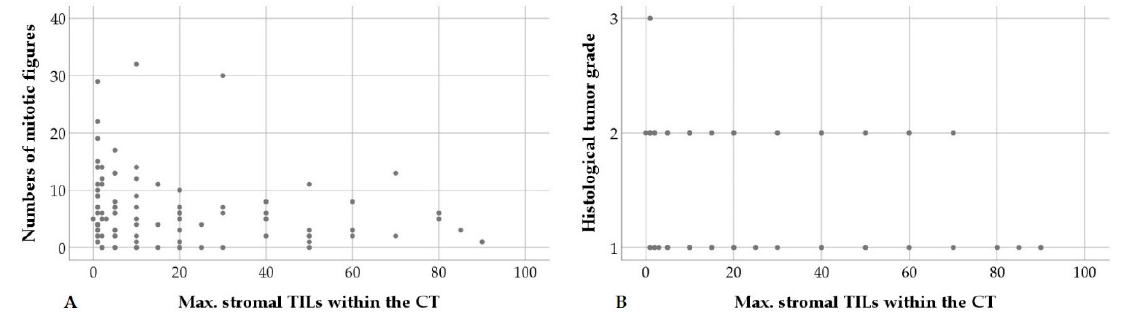
Figure 6. Higher maximal (max.) stromal tumor infiltrating lymphocytes (TILs) per 20 × objective field of view (FOV) within the central tumor (CT) are statistically correlated with decreased numbers of mitotic figures per ten 40 × HPFs ( A ) and a lower histological tumor grade ( B ). No statistical association was observed between evaluated TIL parameters and the ER α / PR status.